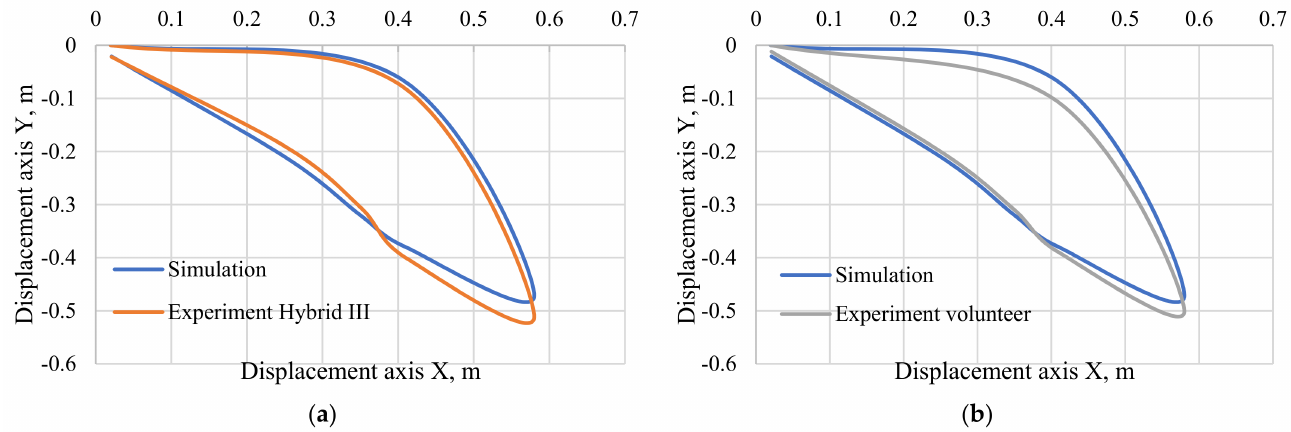
Figure 8. Head movement trajectory; ( a ) head displacement comparison for the simulation dummy and the Hybrid III dummy, ( b ) head displacement comparison for simulation dummy and volunteer.